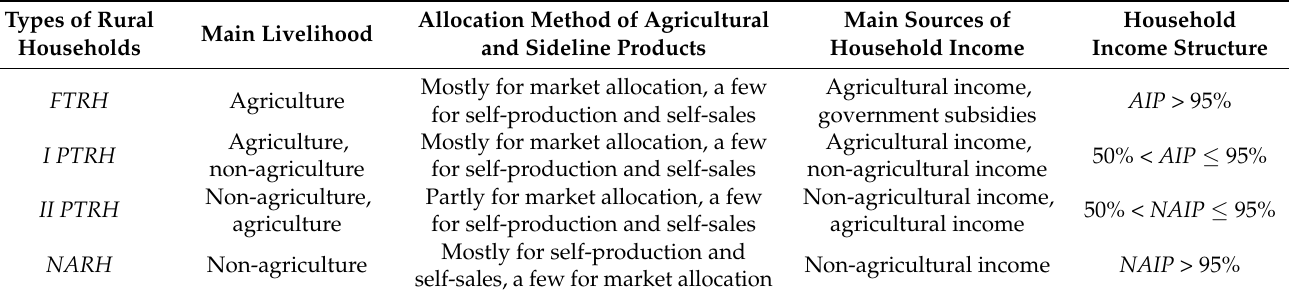
Table 1. Criteria for classifying rural household types